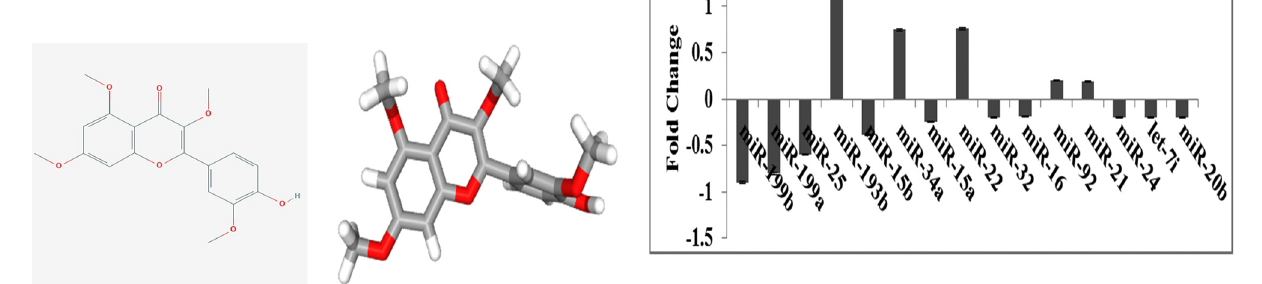
Figure 6: E ff ects of AA treatments on miRNA expression in MDA - MB - 231 cell line. Microarray pro fi le of miRNA expression in MDA - MB - 231 cells treated with AA for 48 h. The relative increase or decrease